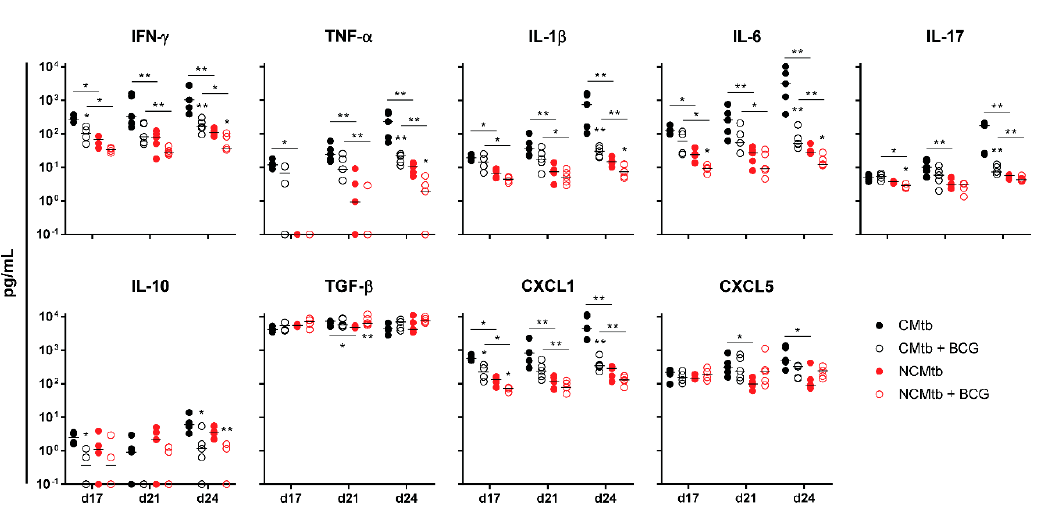
Figure 4. Impact of BCG vaccination on the immune response in lungs. Analysis of inflammatory mediators in lung homogenates at days 17, 21 and 24 PI. Results are represented as log10 of the concentration in pg/mL. Each circle represents an animal and lines are medians. Asterisks indicate differences within the same batch; bar and asterisks indicate differences between batches. Mann–Whitney test (* p < 0.05, ** p < 0.01).